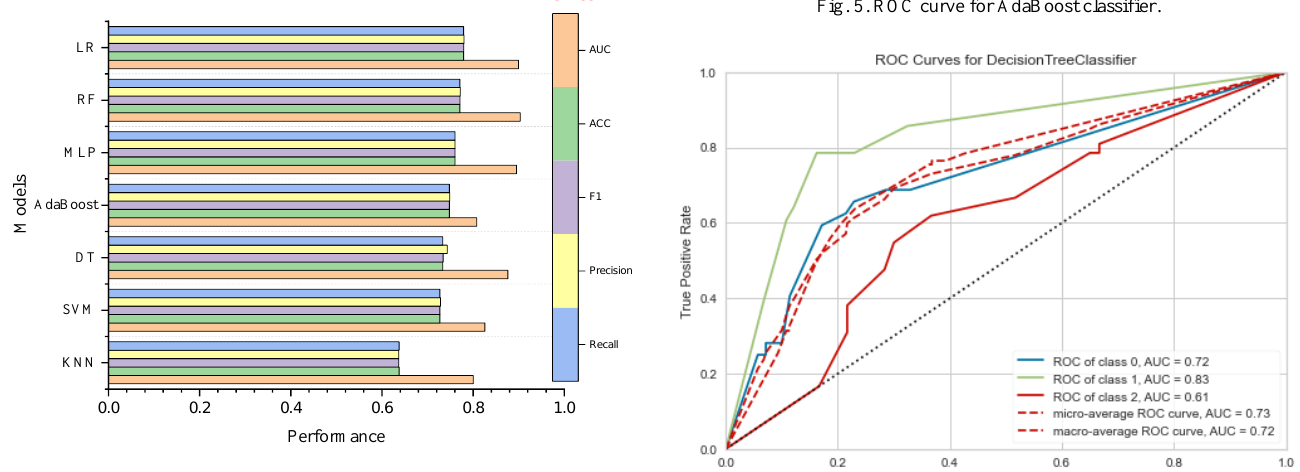
Fig. 5. ROC curve for AdaBoost classifier.